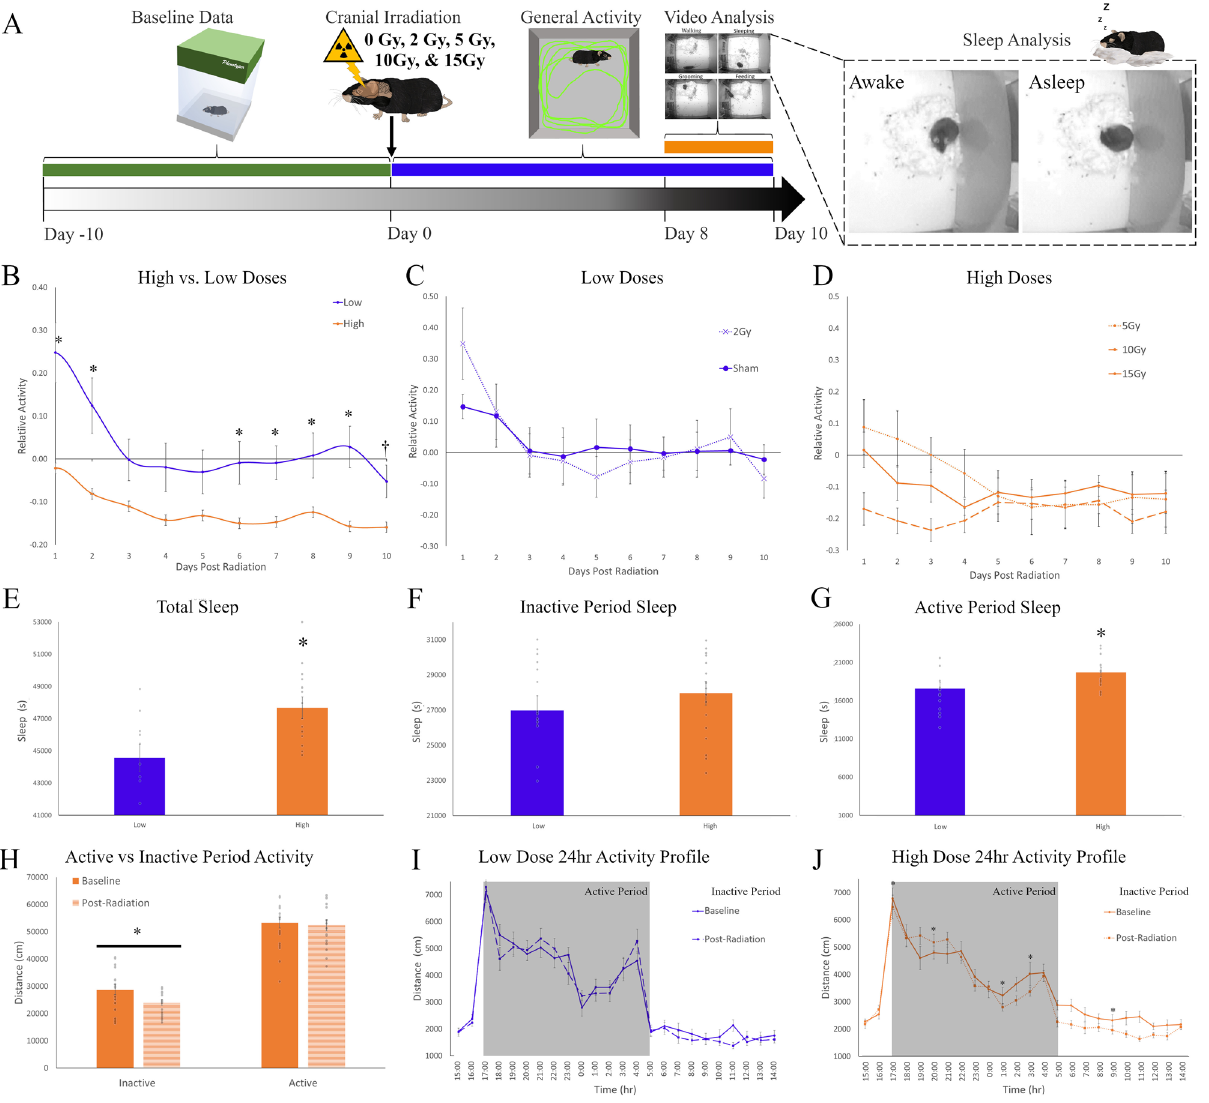
Figure 1. Radiation dose response analysis in mouse CRIH model. ( A ) The dose response curve experimental timeline with mice exposed to 0, 2, 5, 10 or 15 Gy radiation (n = 6/group). Mice were monitored in Noldus Phenotyper™ cages for 10 baseline days (green), general activity data (blue) were then collected for 10 days post-irradiation and other specific behaviors where characterized using the Mouse Behavioral Module from video from day 8–10 (orange). These behaviors include drinking, grooming, feeding and sleep-like behavior (inlet). ( B ) Relative general activity levels mapped across 10 days post-treatment when groups were divided into high (5, 10 & 15 Gy; orange) or low (0 & 2 Gy; blue) radiation levels. Activity levels were standardized to produce relative activity values by dividing the 24 h of post-treatment for all 10 days by the average baseline activity levels. Comparisions of high and low radiation levels had significant main effects (time: F(9,234) = 11.686, p < 0.001; radiation dose: F(9,234) = 7.703, p = 0.010) and an interaction between time and level of radiation (F(9,234) = 2.195, p = 0.023). Posthoc tests (tukey) were significant if p < 0.05 ( C ) Low dose groups remained close to baseline levels (0.0), except for the first two days post-treatment. ( D ) High dose groups across 10 days post-treatment showed least a 10% decrease in activity by the 6th day post-radiation, with the greatest effects observed in the 10 (dashed line) and 15 (solid line) Gy. E Total sleep levels were significantly higher in the high dose animals than the low dose mice in the last 3 days of